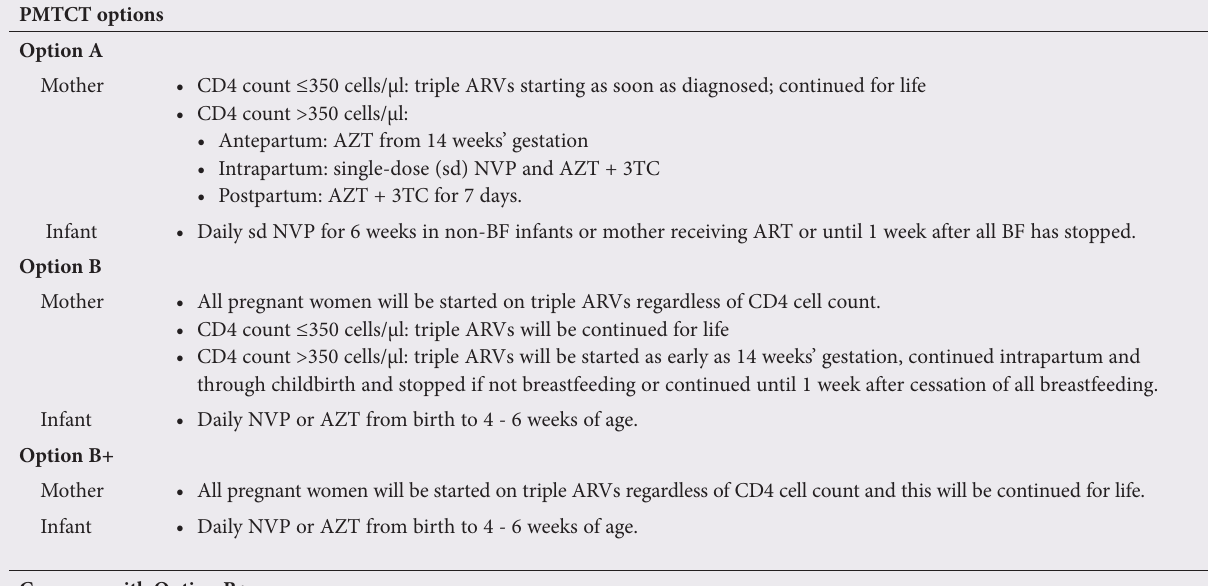
Table 1. Summary of PMTCT options and concerns with Option